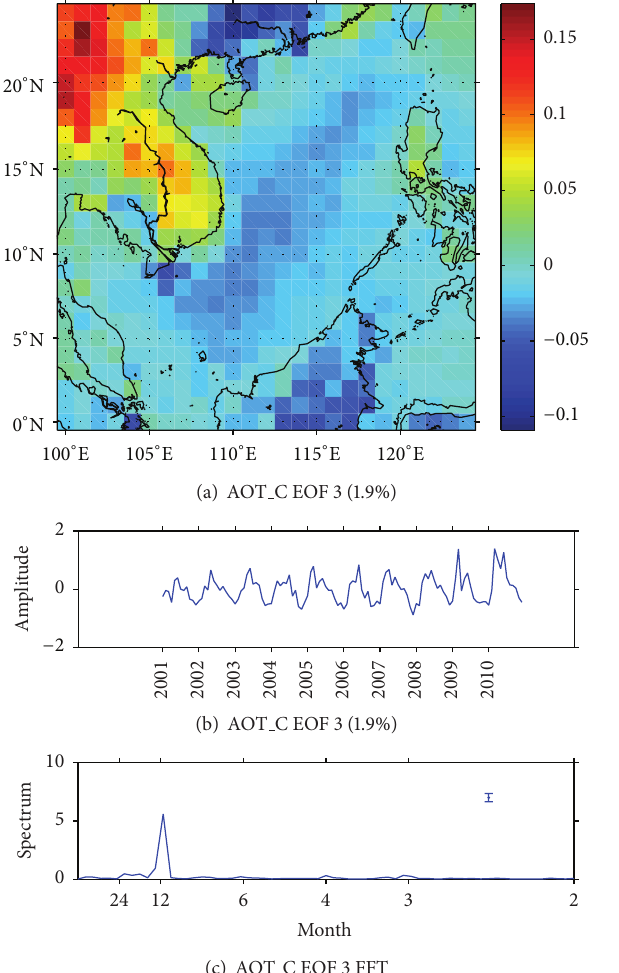
Figure 4: The same as Figure 2 but EOF mode 3 of AOT C.